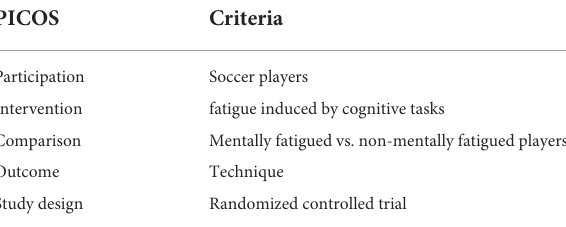
TABLE 1 Eligibility criteria based on PICOS (participation, intervention, comparison, outcome, and study design).